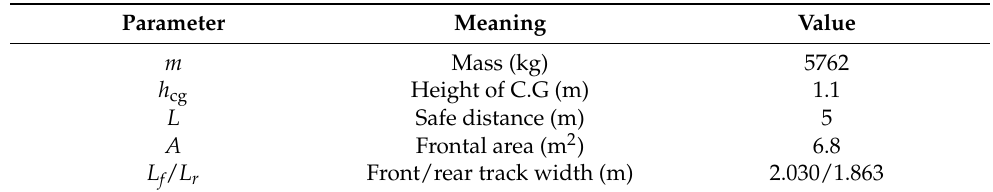
Table 2. Main parameters of vehicle LCF Van dynamics.